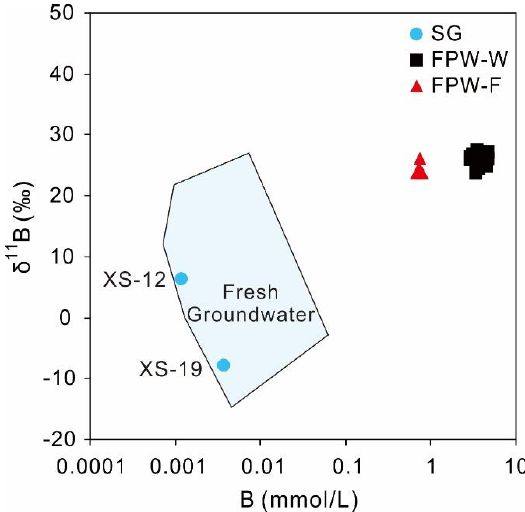
Figure 7. The plot of δ 11 B versus B for shallow groundwater, FPW-W, and FPW-F. Data of fresh